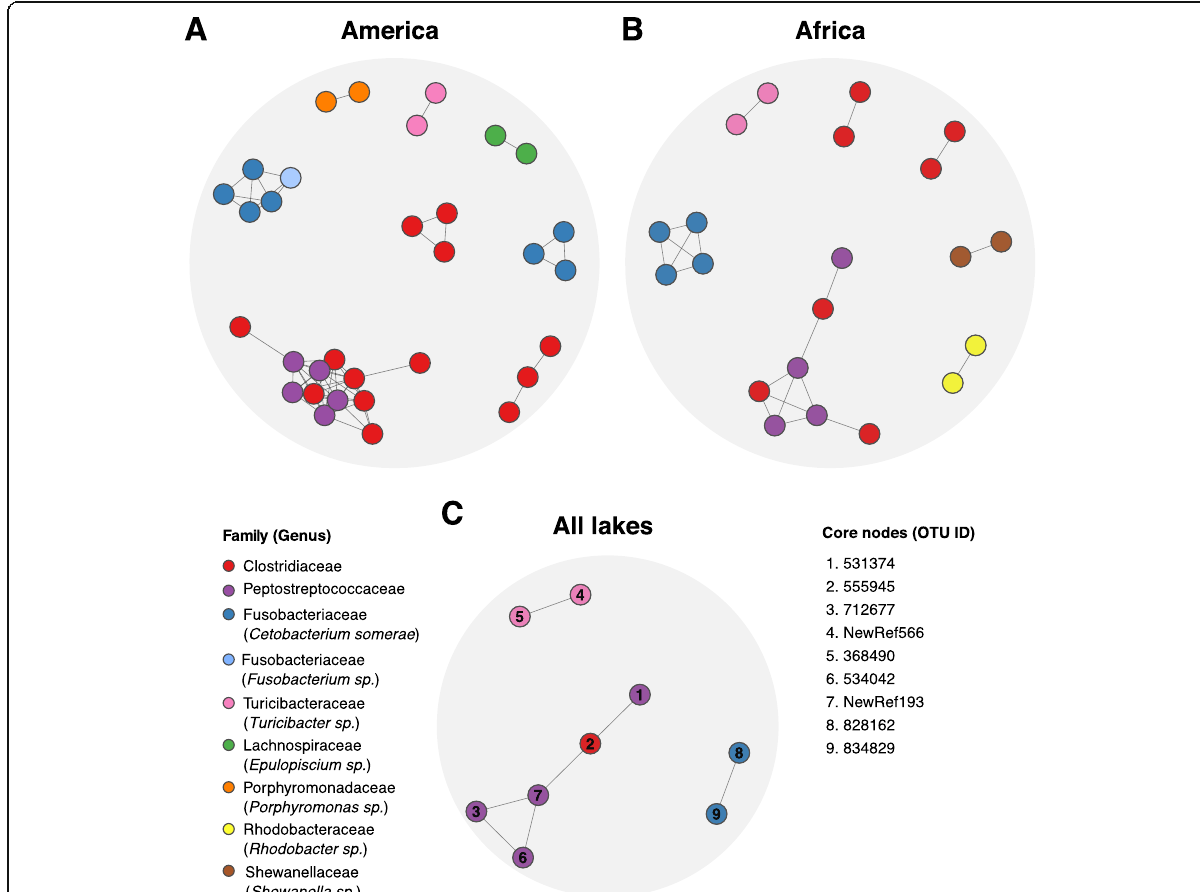
Fig. 3 Core networks of common pairwise associations across geographical graphs. a-c Shared associations across the four American lakes (Nicaragua, Apoyo, Apoyeque and Xiloá; 60 edges, 32 nodes) ( a ), the two African lakes (Tanganyika and Barombi Mbo; 20 edges, 21 nodes) ( b ), and all lakes (7 edges, 9 nodes) ( c ). Nodes are colored according to the maximum taxonomic resolution achieved. Nodes in c are labelled by their OTU ID (right panel, for full taxonomic classification and abundance across samples, see Additional file 1: Table